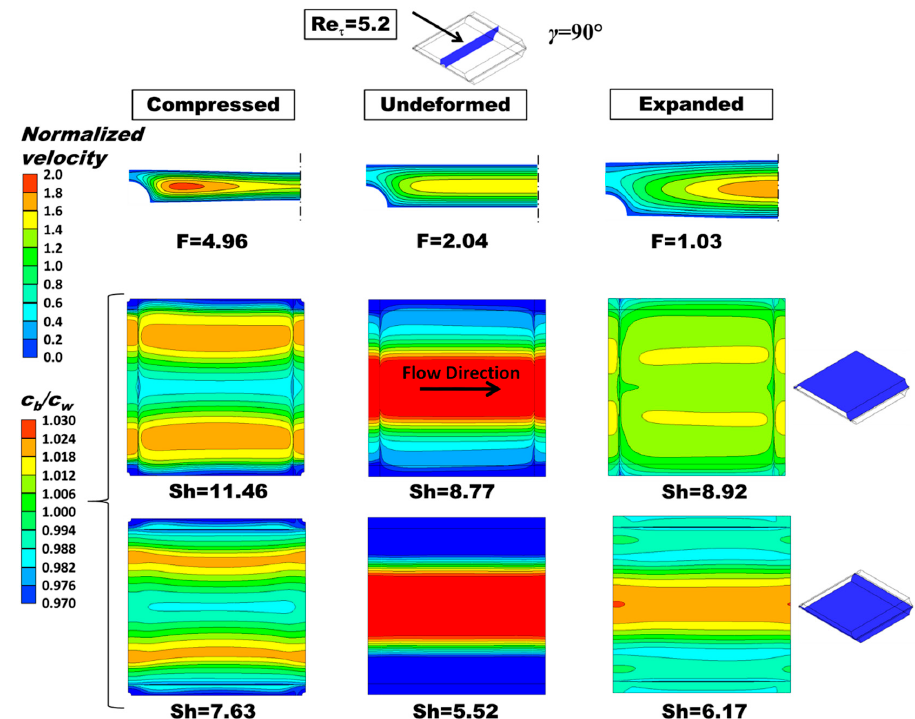
Figure 6. Influence of deformation on flow and mass transfer for P/H = 8, γ = 90°. Left column: compressed (TMP = + 0.4 bar); middle column: undeformed; right column: expanded (TMP = − 0.4 bar). Top row: distribution of the streamwise velocity component in the central cross section of the channel (for symmetry reasons, only half map is shown); middle and bottom rows: distribution of the polarization coe ffi cient on the upper and lower walls (see sketches on the right). c b = 500 mol / m 3 , flux corresponding to a current density of 50 A / m 2 entering the fluid domain (dilute channel of RED or a concentrate channel of ED). F ratio and Sherwood number are also reported.